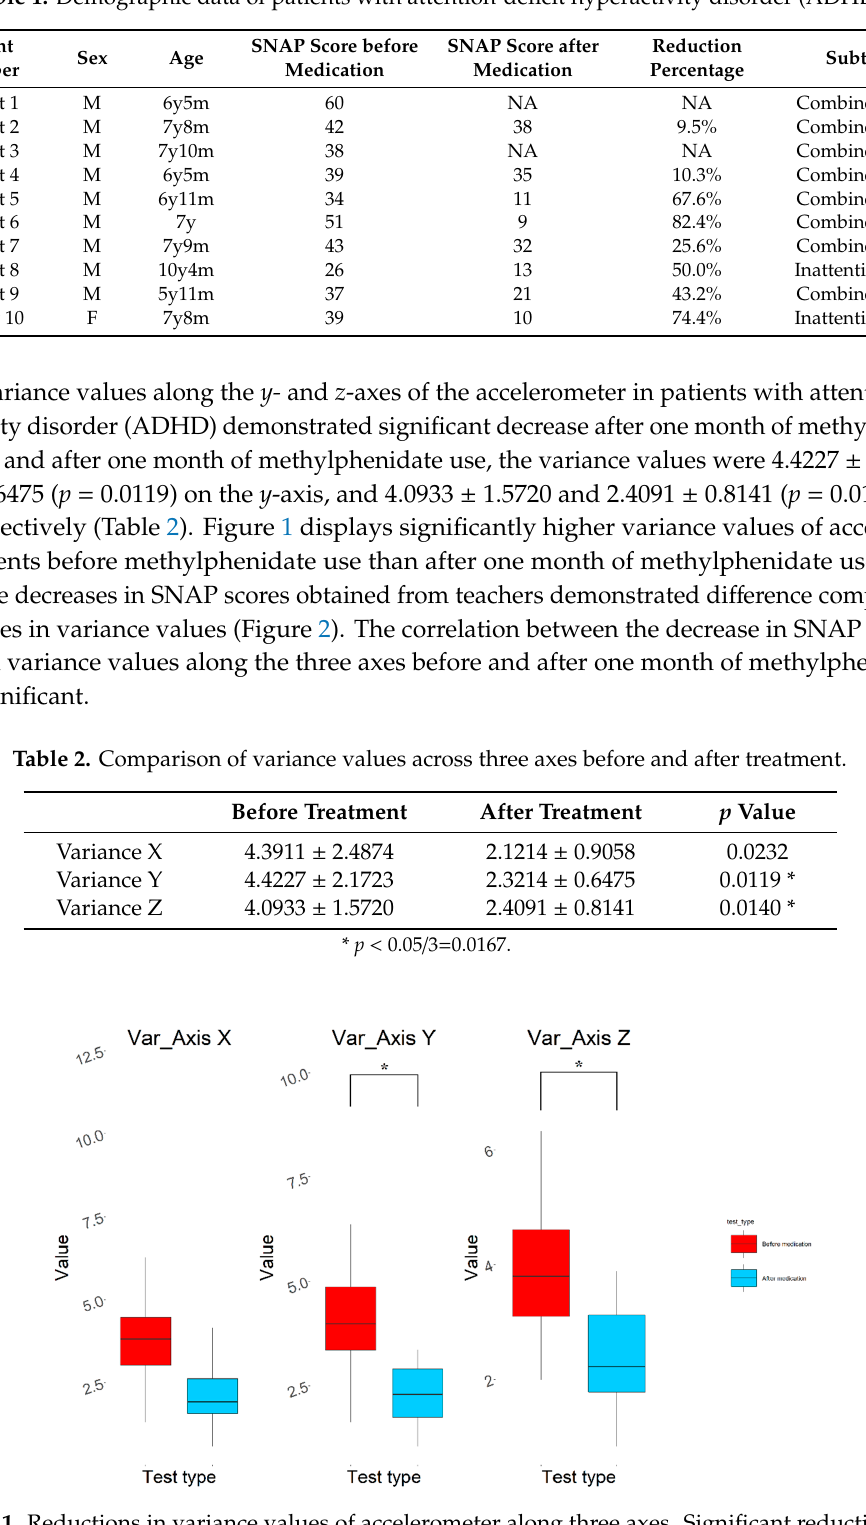
Table 1. Demographic data of patients with attention-deficit hyperactivity disorder (ADHD).